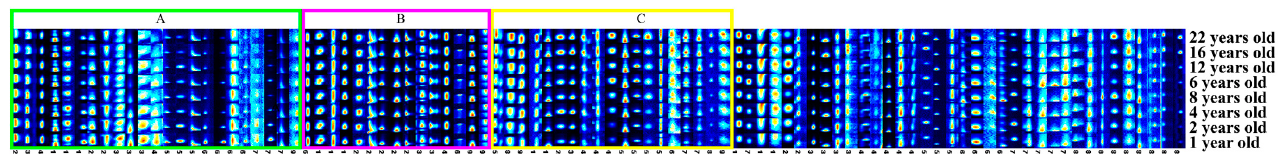
Figure 3. Gallery plot of the intensities of all the identified compounds in samples A1–A22 detected by GC-IMS. The codes of the compounds correspond to those in Table 1. (The intensities of the signal peaks in frame A generally decrease for each year; the intensities of the signal peaks in frame B have no obvious differences; the intensities of the signal peaks in frame C generally increase for each year)